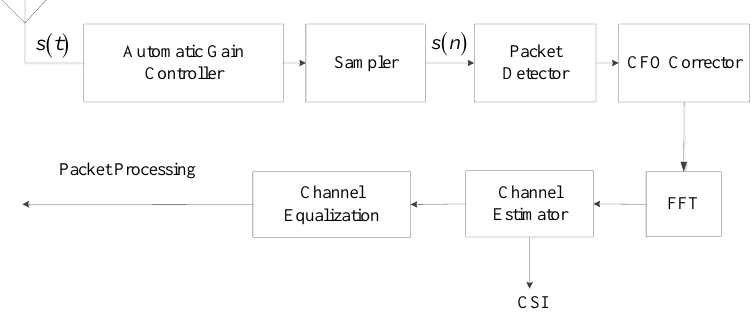
Figure 3. Flow chart of signal processing under the 802.11n